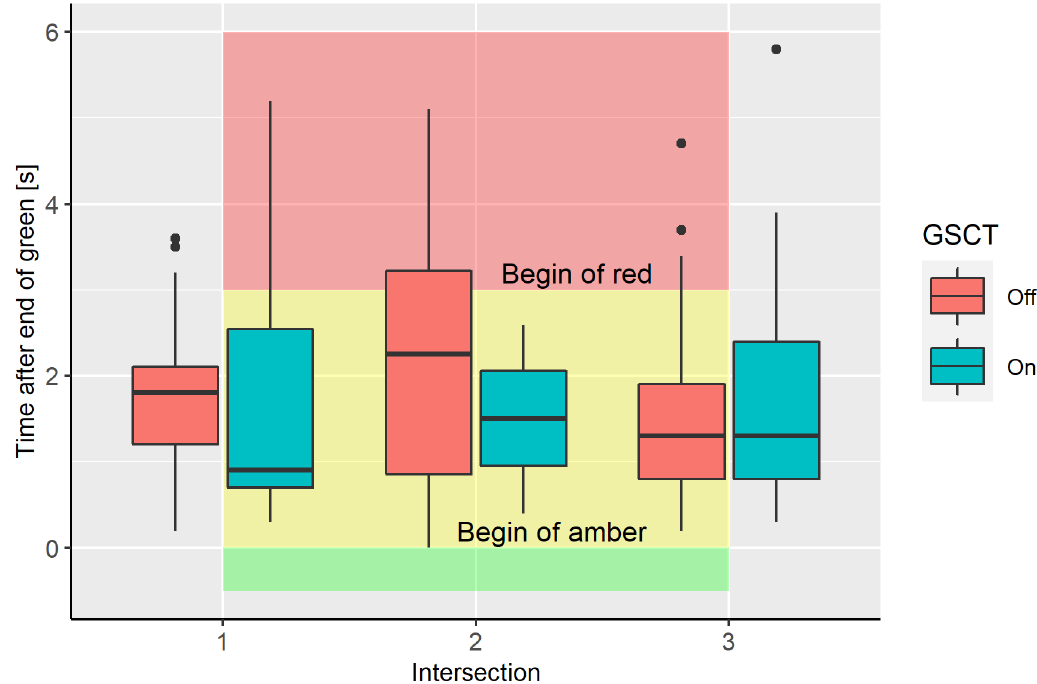
Figure 9. Boxplots of the time of entry after the end of the green signal. Additionally, for the entire population of registered entries after the end of the red signal, a histogram of the entry time measured from the end of the green signal was developed, as shown in Figure 10. Both graphs show the moment of the signal change to red. The red color refers to the situation with the GSCT turned off, and blue color with the GSCT turned on. Figure 10. Histogram of entry times after the end of the green signal (data from all intersections).